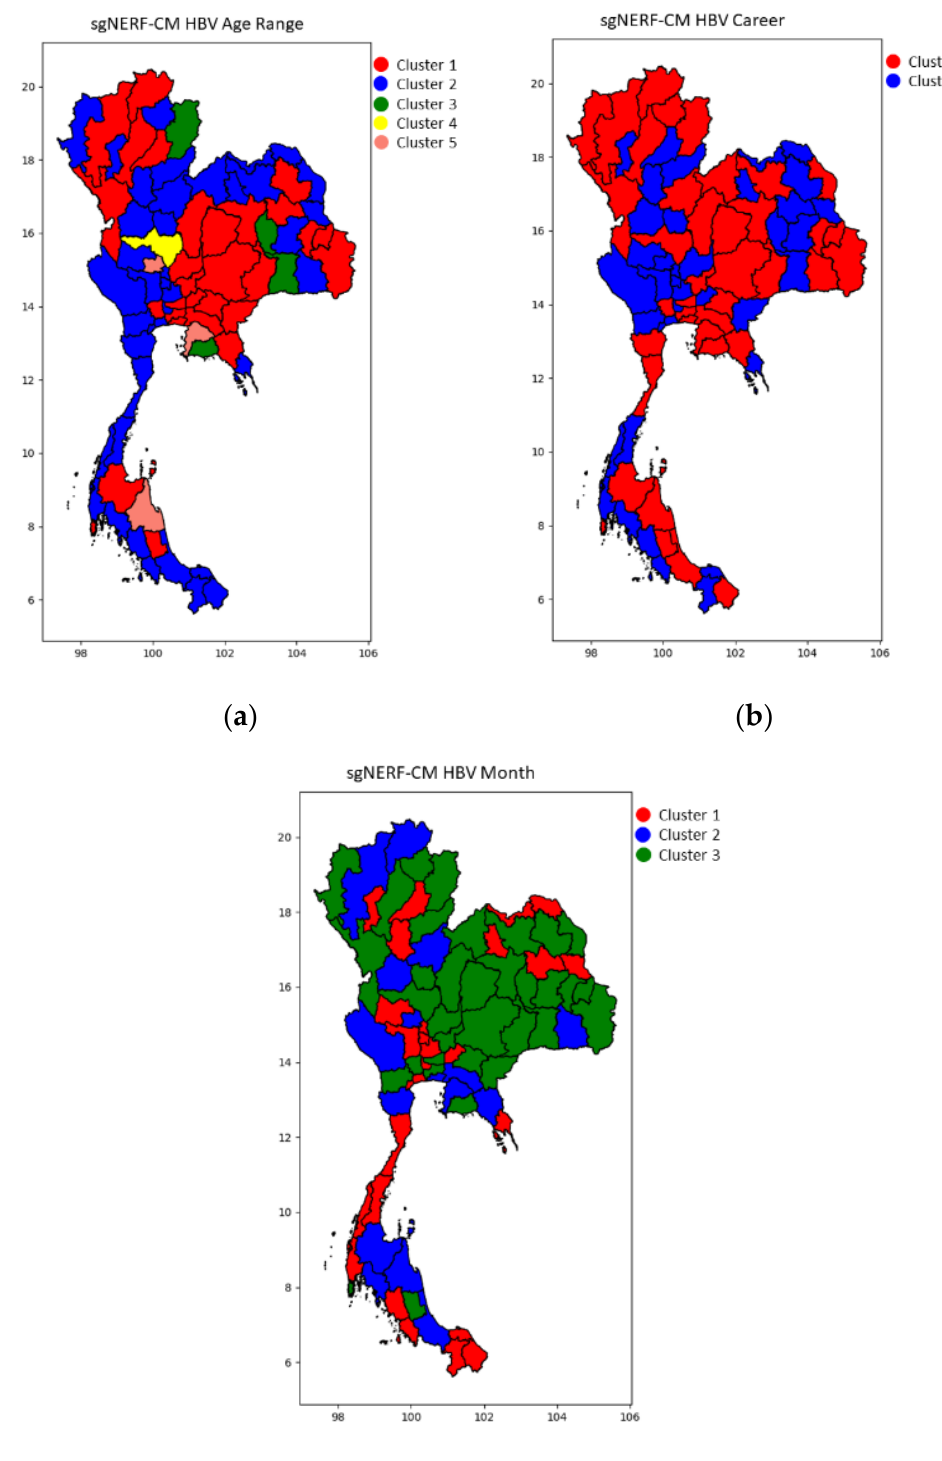
Figure 4. The blind test results for the HBV dataset for ( a ) age range, ( b ) career, and ( c ) month category using the best models from sgNERF-CM algorithm.